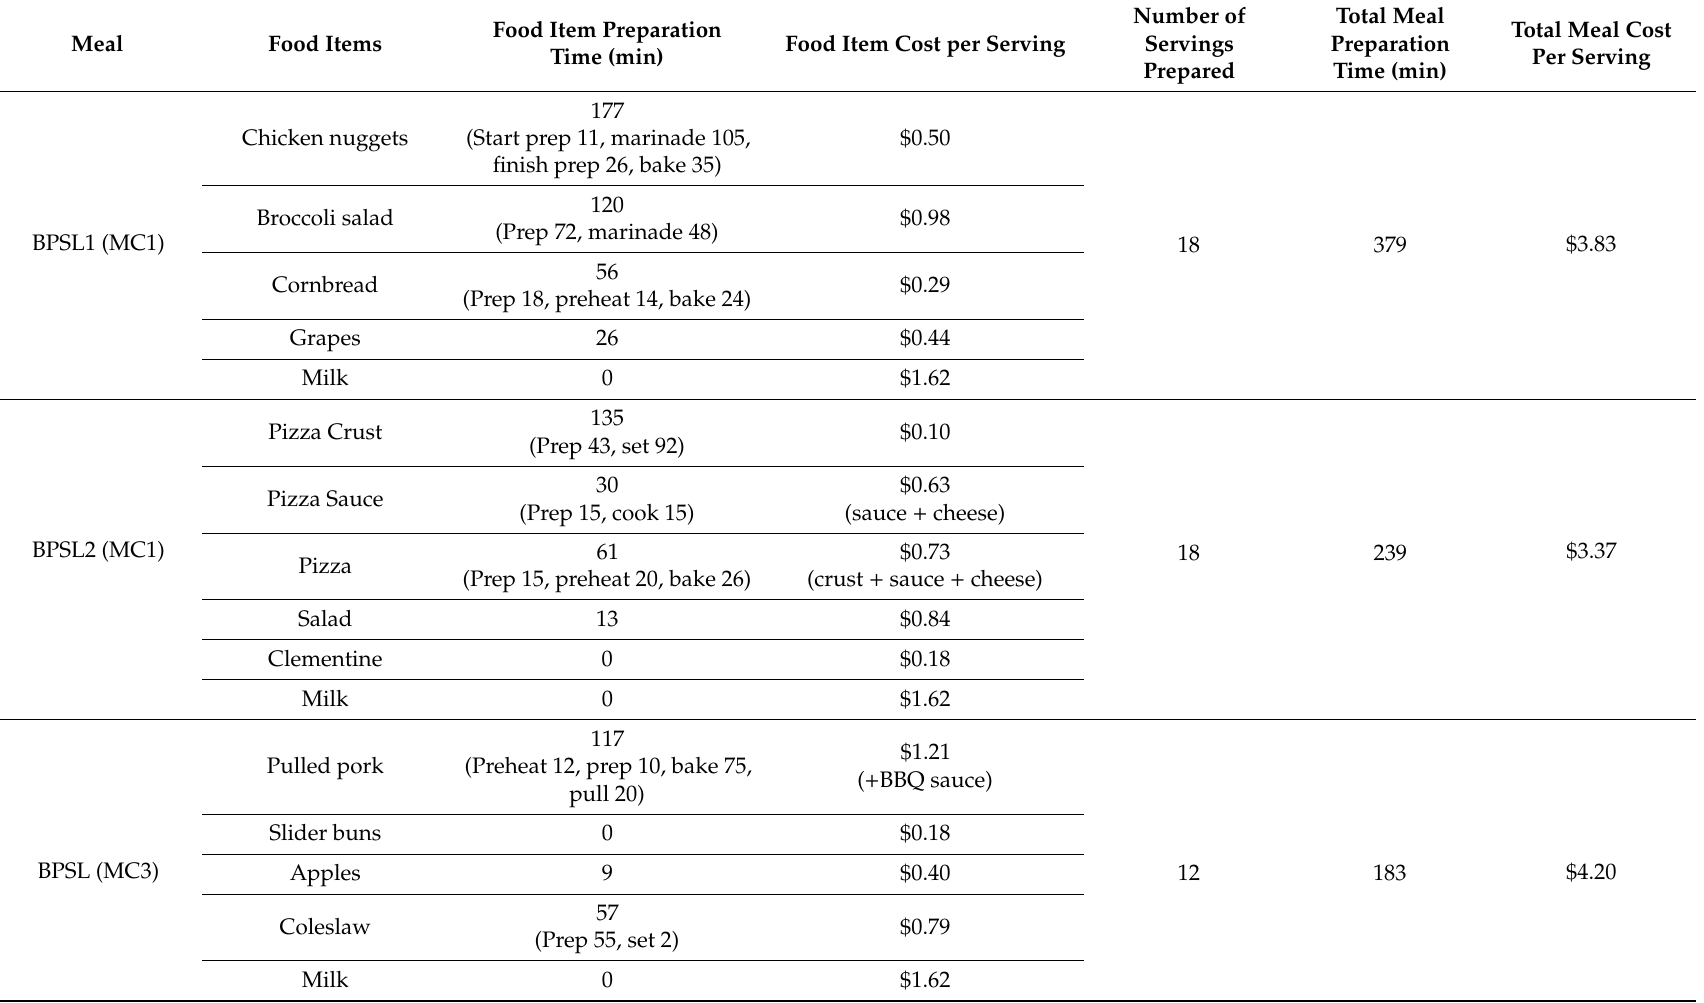
Table 4. Comparison of preparation time and cost for meal